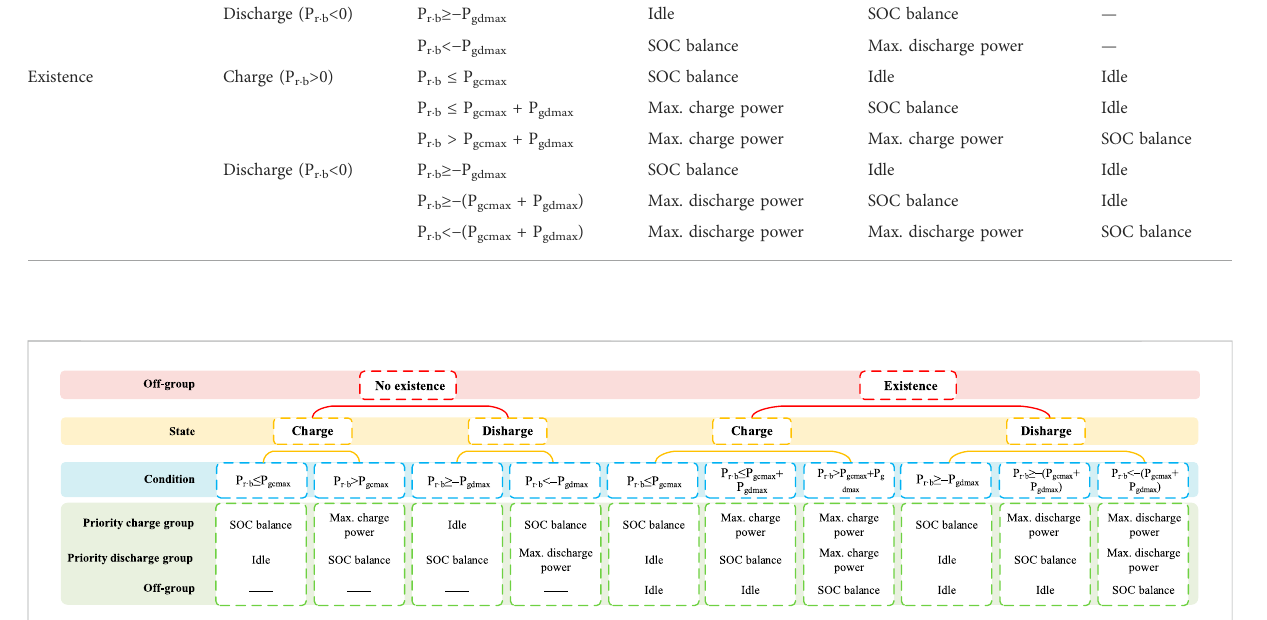
FIGURE 4 Power distribution principle for battery units in each battery group with different